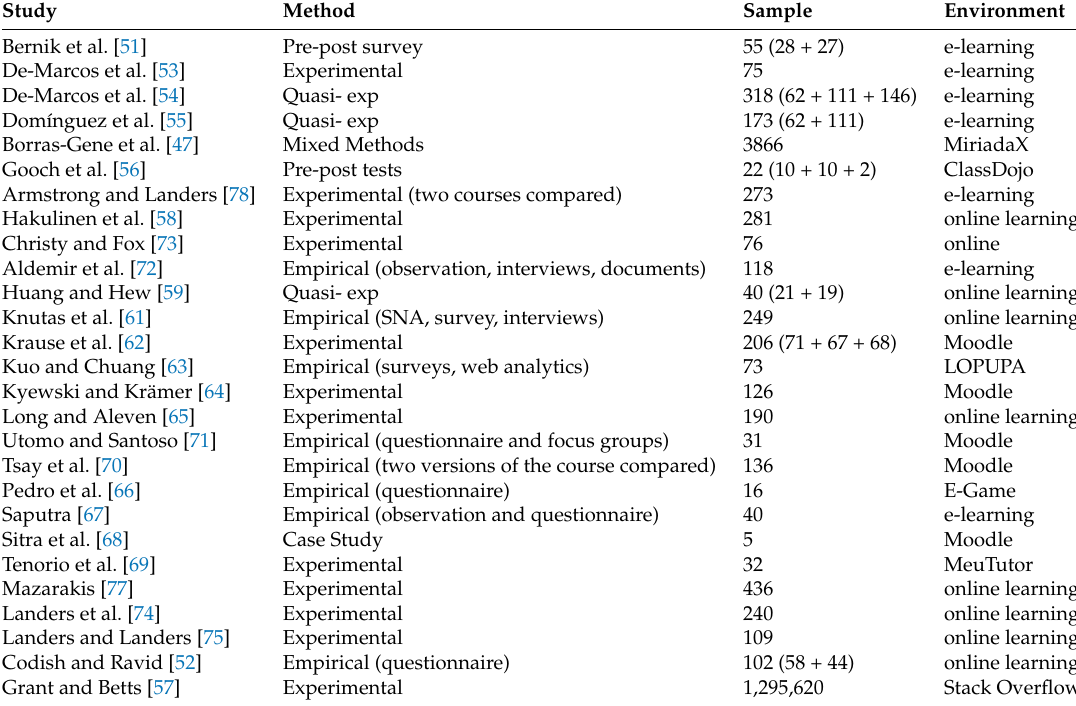
Table A1. Methods used in the studies included in this systematic literature review, with details about sample and environment